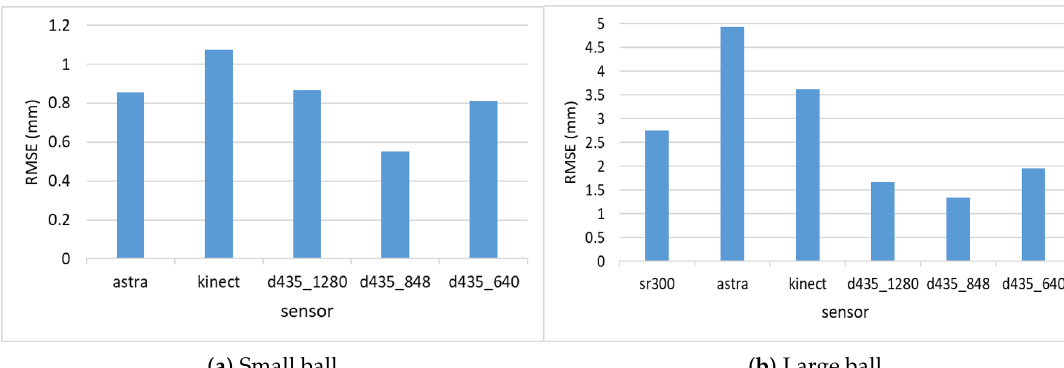
Figure 7. RMSE for diameter estimation of the two balls.